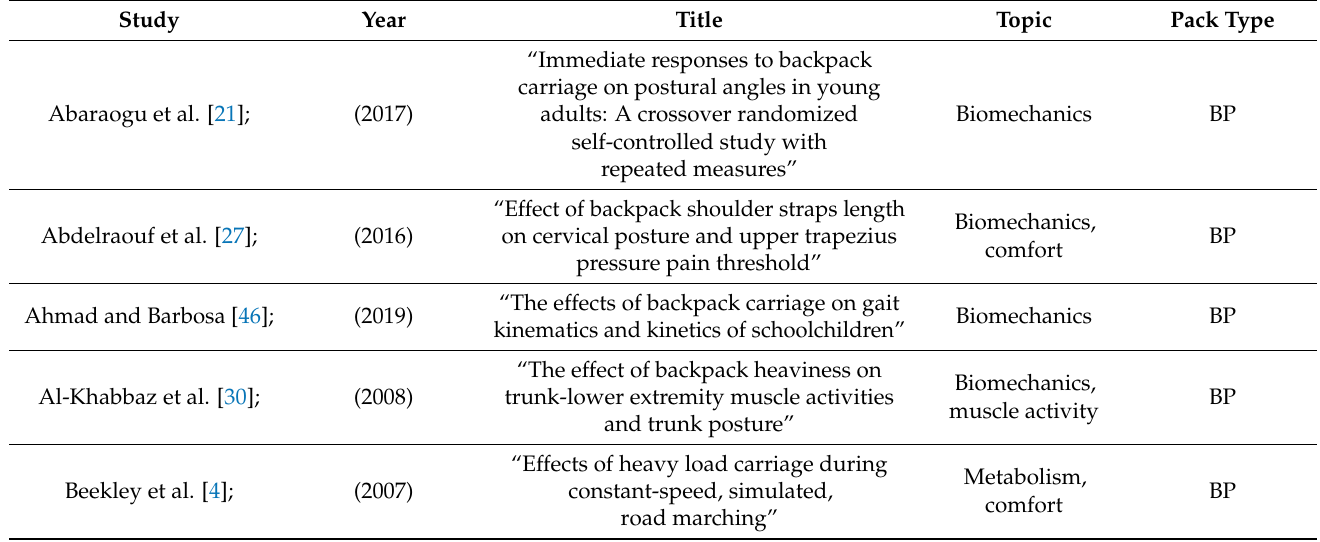
Table 1. Included articles. Abbreviations: BP = backpack, DP = double pack, FP = front pack, TP =